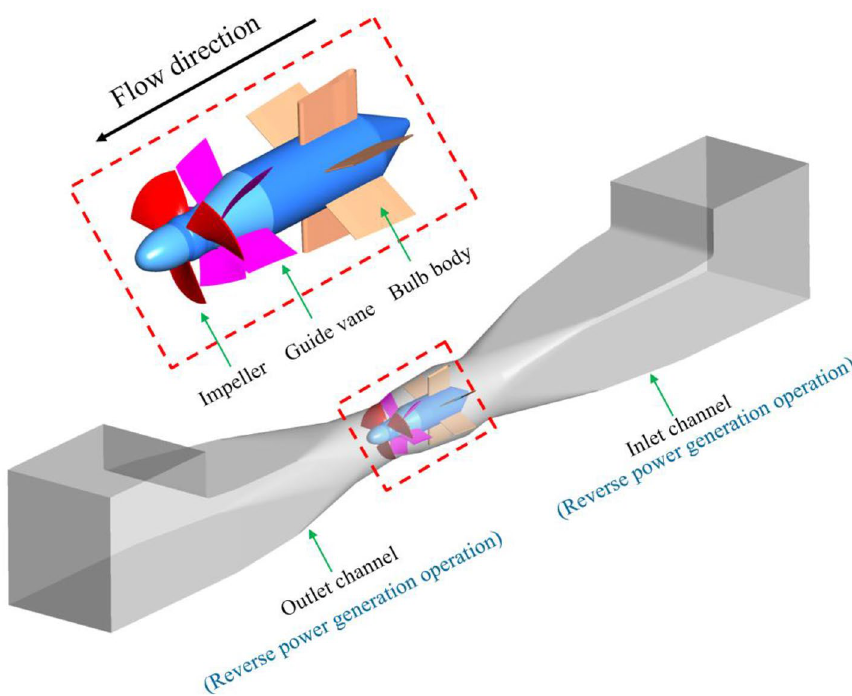
Figure 1. Three-dimensional model of a large axial flow pump system for reverse power generation